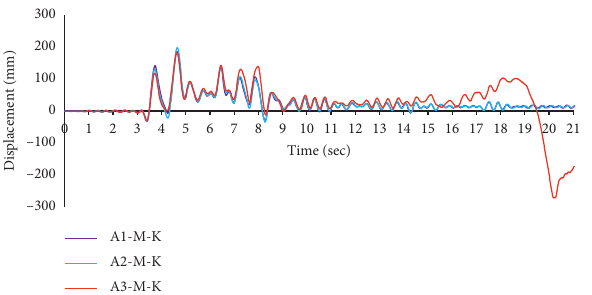
Figure 15: Displacements–time history of the right column of models “A1-M-K, A2-M-K, and